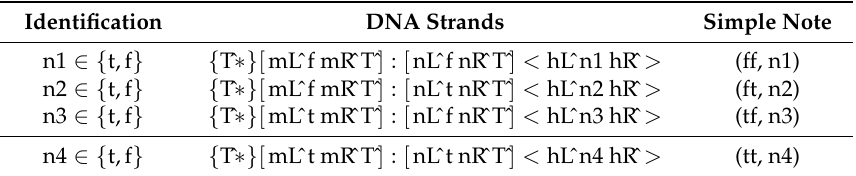
Table 1. Double strands of the 2-input mapping Table 1 . Double strands of the 2-input mapping module.